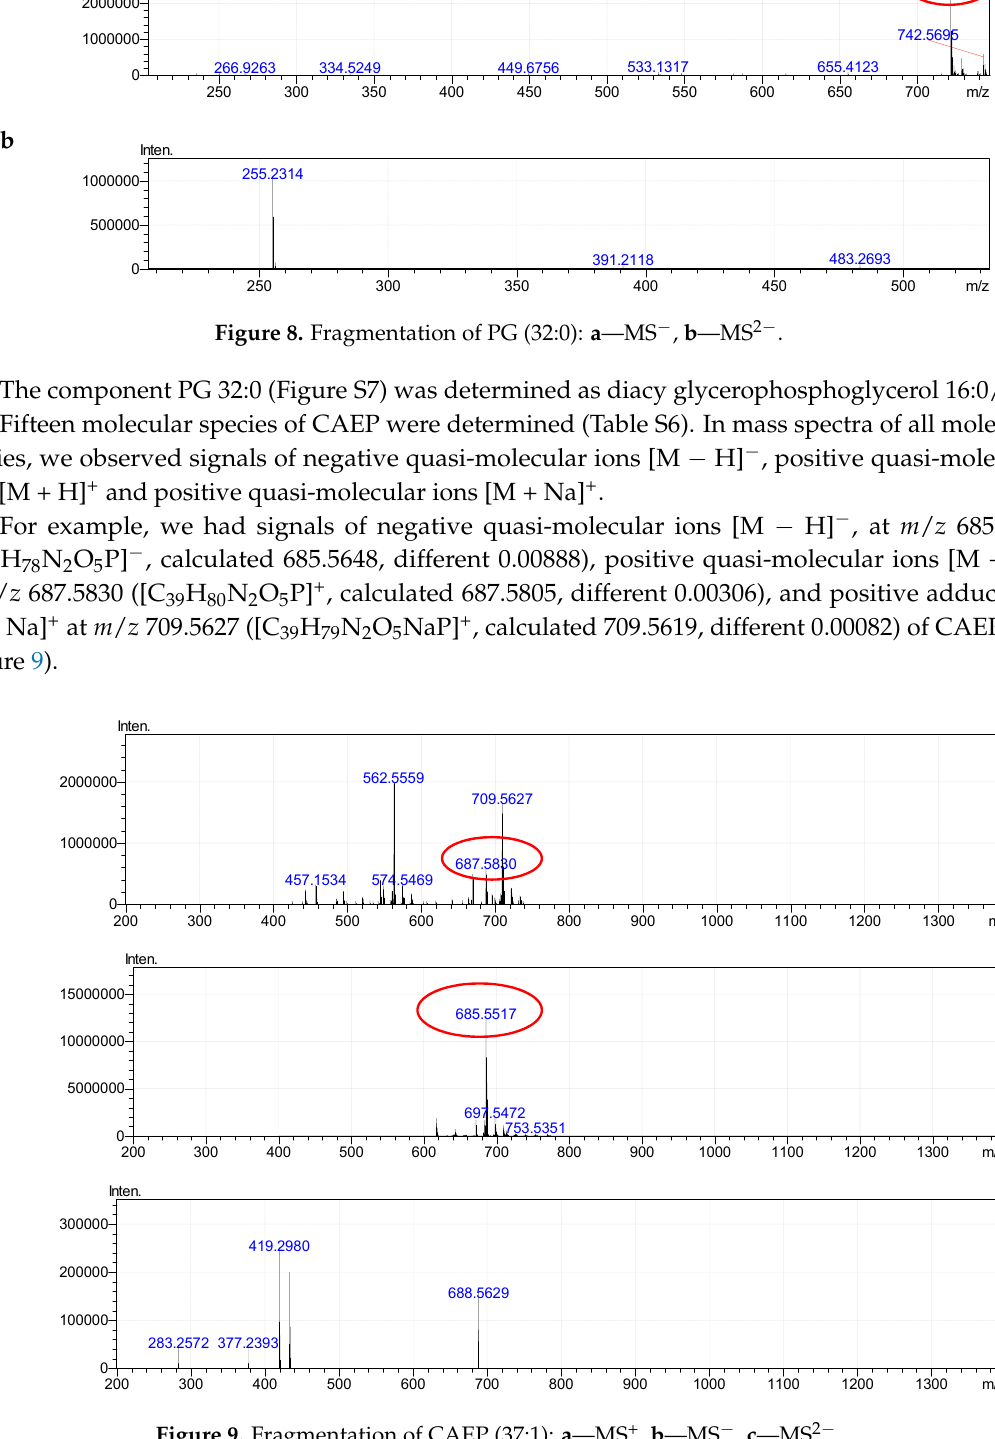
Figure 7. Fragmentation of PI (40:5): a —MS − , b —MS 2 − . The component PI 40:5 (Figure S6) was determined as diacy glycerophosphoinositol 20:1/20:4. We determined a single component, which was isomers of PG 32:0 constituting